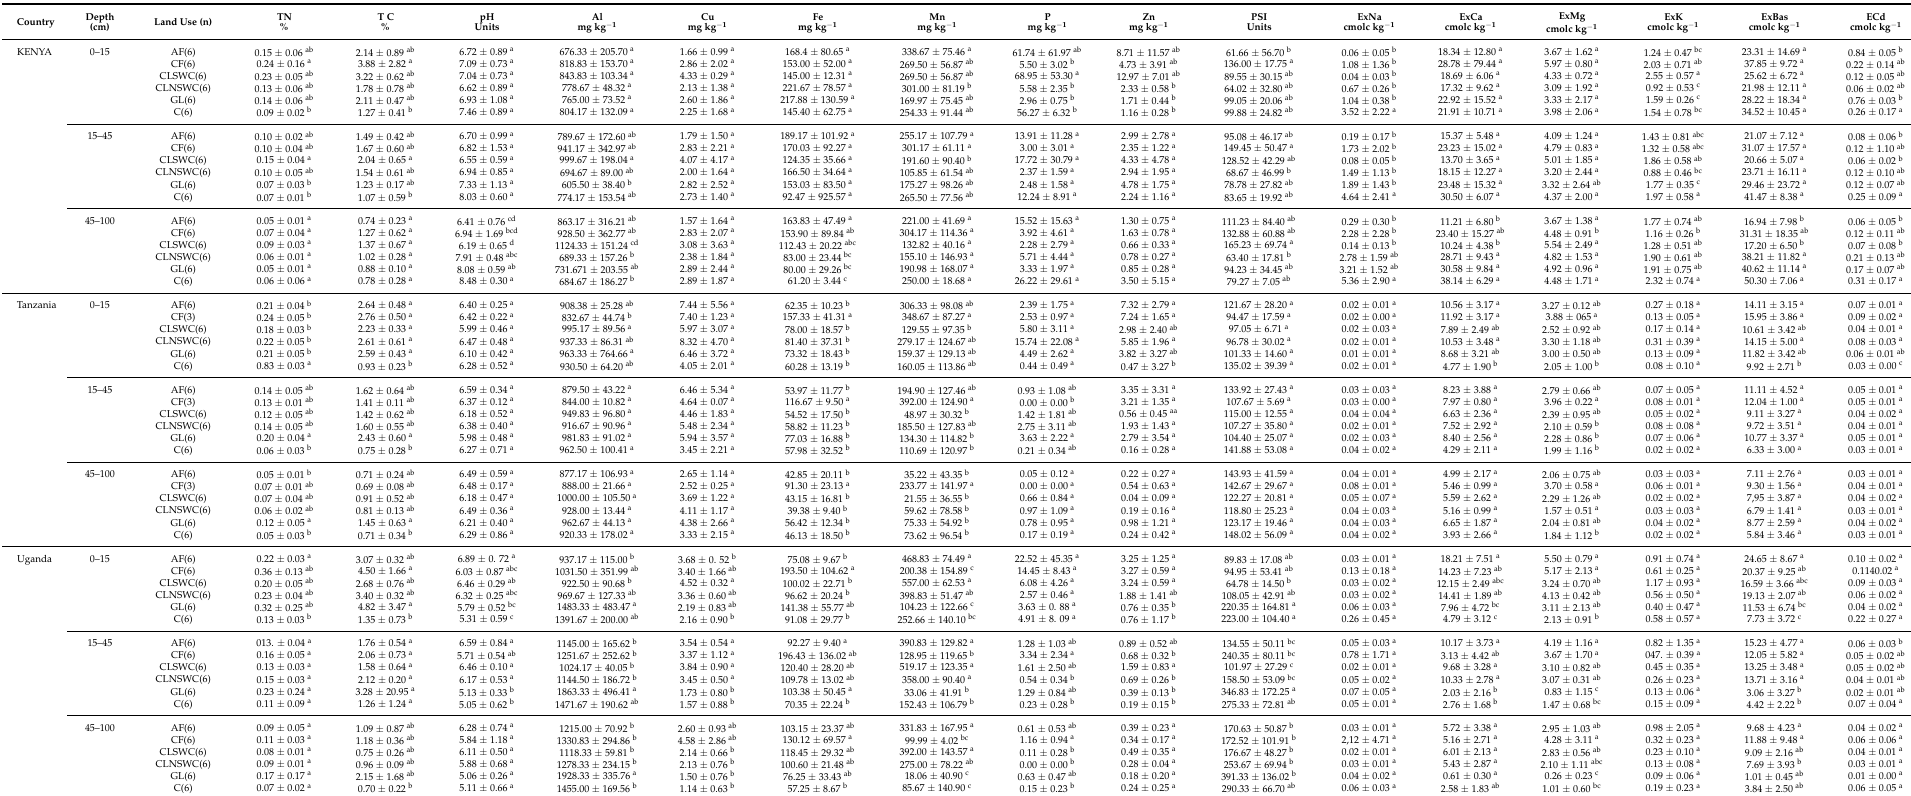
Table 3. Soil quality indicators in different land uses in three countries at different depths as predicted by the ensemble algorithm on NIR